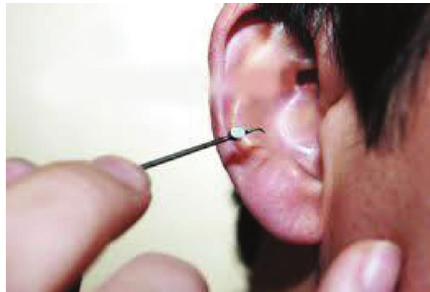
Figure 2: The method of inserting the bluetooth device in the external auditory